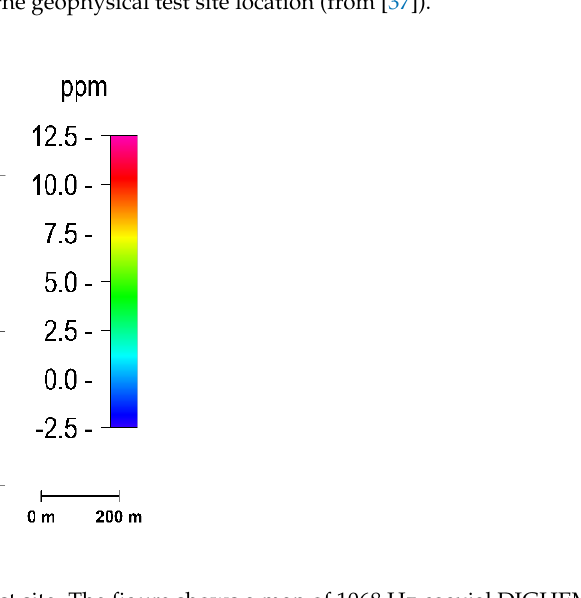
Figure 2. The Reid-Mahaffy test site. The figure shows a map of 1068 Hz coaxial DIGHEM data. We have applied the standalone inversions to both DIGHEM and TMI data.